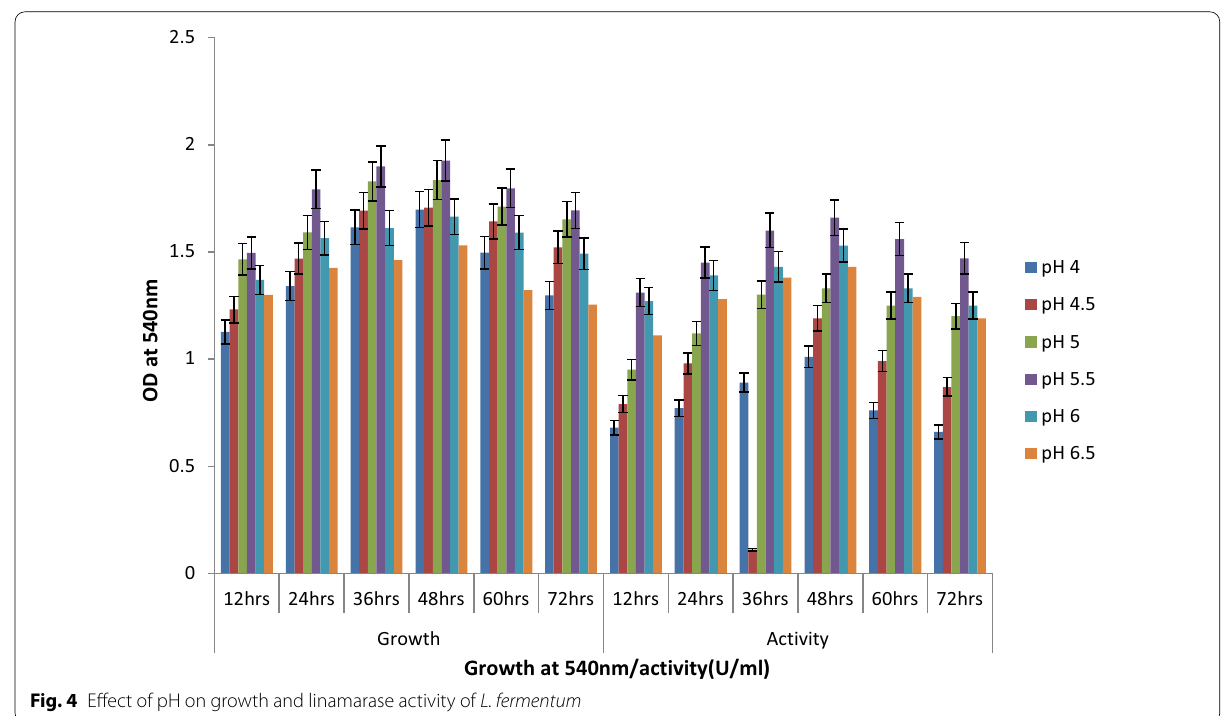
Fig. 4 Effect of pH on growth and linamarase activity of L. fermentum